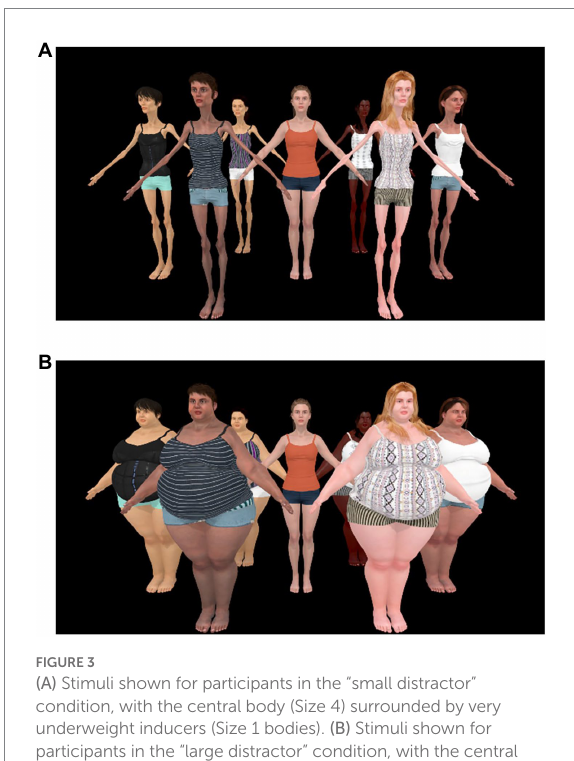
FIGURE 3 (A) Stimuli shown for participants in the “small distractor” condition, with the central body (Size 4) surrounded by very underweight inducers (Size 1 bodies). (B) Stimuli shown for participants in the “large distractor” condition, with the central body (Size 4) surrounded by six very overweight inducers (Size 7 Bodies). The stimuli was created using ©Character Creator and using Shape Keys (e.g., an animation industry technique which smoothly interpolates between the vertices of the two models) to create the intermediate body types by linearly interpolating between the Size 1 and Size 4